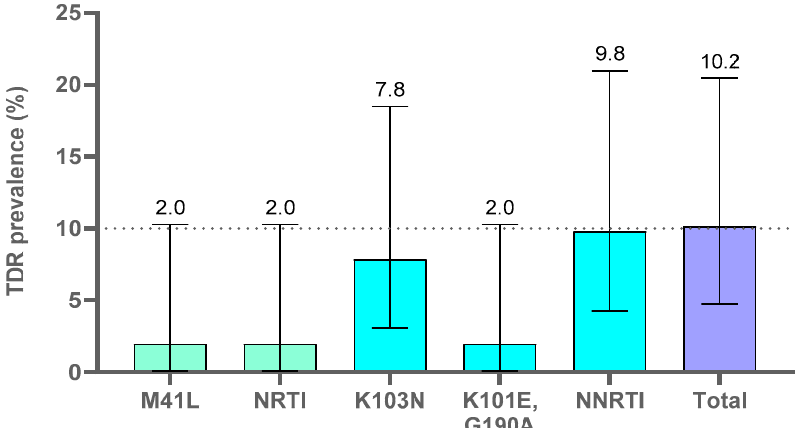
Figure 4. Transmitted pretreatment drug resistance mutations identified by WHO TDR list 2009 in the 59 naïve adults. Available sequences in 59 naïve adults of EG: 58PR, 51RT, 41IN (see Table S1). TDR, transmitted drug resistance mutations; naïve, ART-naïve. NRTI, nucleoside reverse transcrip- tase inhibitors; NNRTI, non-NRTI; total, total TDR found in the available pol coding regions. We considered only major-DRM to PI, INSTI, NRTI and NNRTI, according to WHO TDR list 2009 “https://hivdb.stanford.edu/page/who-sdrm-list/ (accessed on 15 July 2022)” for PR and RT and “https://hivdb.stanford.edu/page/insti-sdrm-list/ (accessed on 15 July 2022)” for IN.